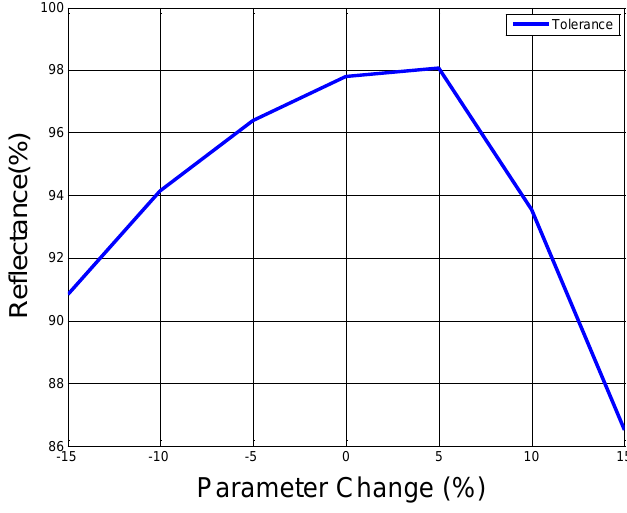
Figure 8. Tolerance analysis of the design parameters of the 1 Layer DBR structure with an added aluminum layer.